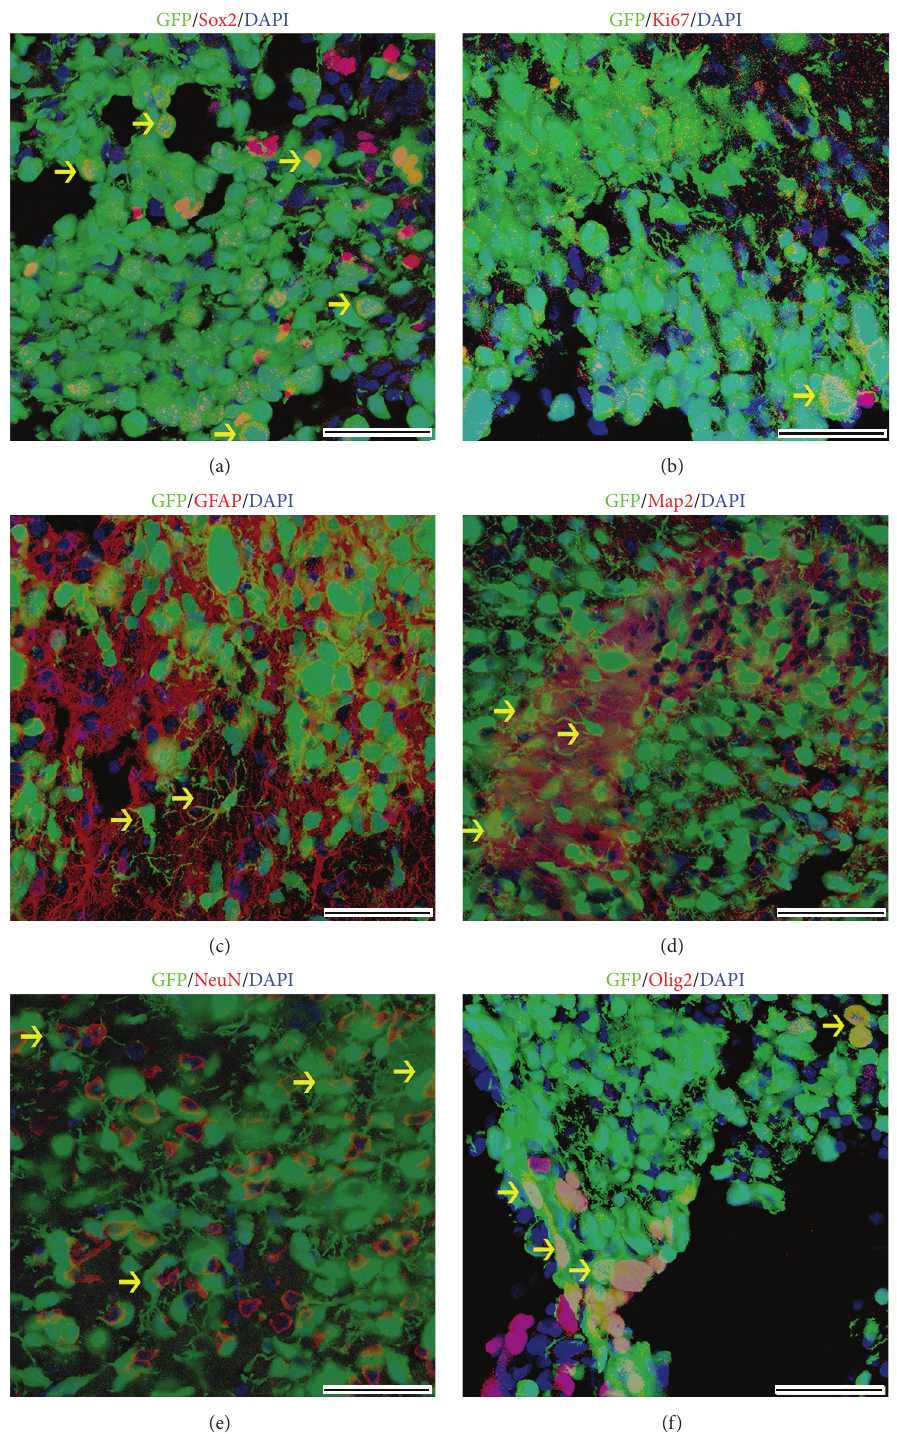
Figure 4: Differentiation of SMINS-TTF-3 cells in vivo . SMINS-TTF-3 cells infected with lentiviral EGFP vectors were injected into the lateral ventricle of brain in nude pups at the age of 3 days and the brains were collected at 6-week point. (a-b) Some injected SMINS-TTF-3 cells remained as neural stem cells, as indicated by neural stem cell marker Sox2/GFP + . Some cells kept the ability of proliferation, as shown by Ki67/GFP + staining. (c–f) The injected cells differentiated into astrocytes (GFAP/GFP + ), neurons (Map2/GFP + and NeuN/GFP + ), and oligodendrocytes (Olig2/GFP + ) in vivo . DAPI was used for nuclei counterstaining (blue). Scale bar: 50 𝜇 m. The arrows direct positive